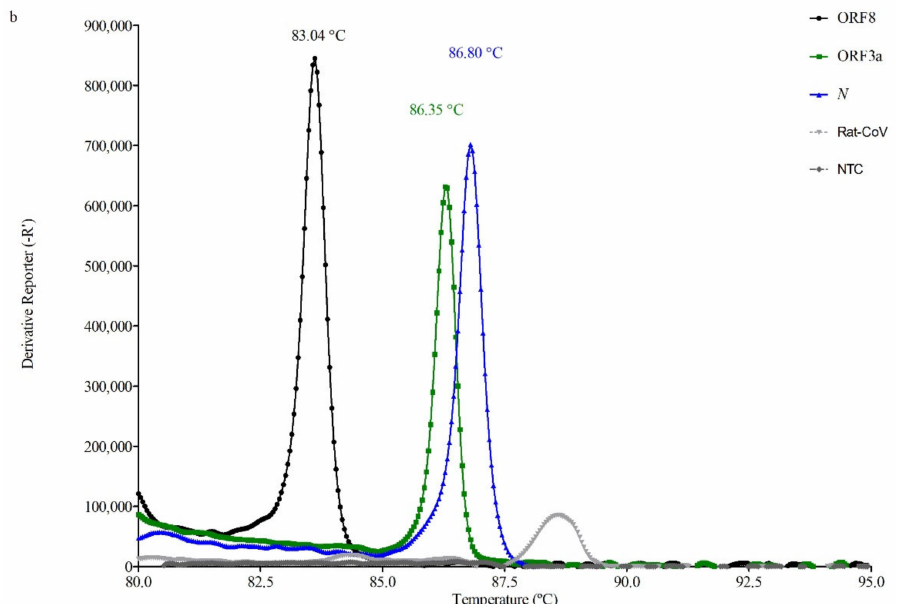
Figure 2. Typical amplification plots ( a ) and melt curves ( b ) obtained with the synthetic control 1 for ORF8, ORF3a, and N . ∆ Rn is the magnitude of normalized fluorescence signal, relative to the baseline fluorescence, generated by the reporter at each cycle during the